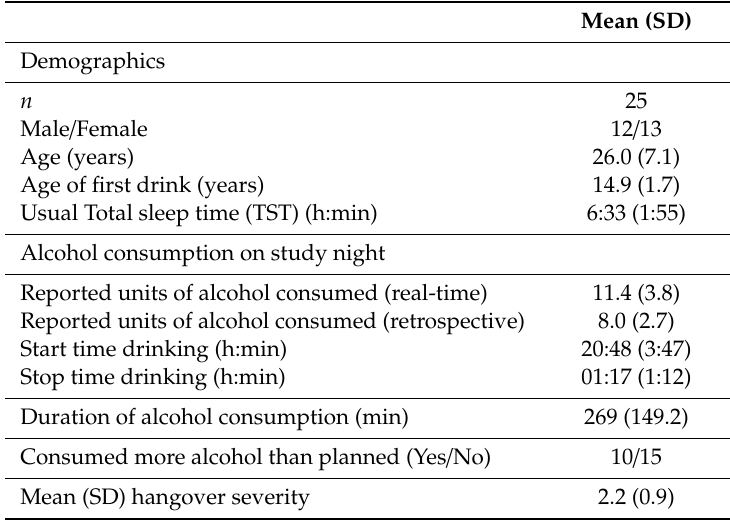
Table 1. Demographics and alcohol consumption characteristics.